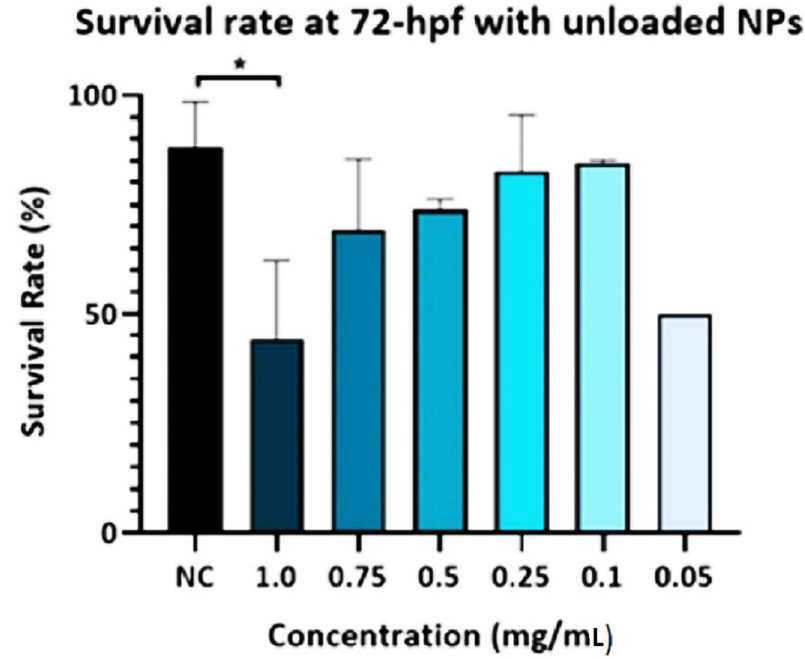
Figure 1. Survival rate of zebrafish embryos exposed to unloaded PLGA-PEG-PLGA NPs. The survival rate of the zebrafish embryos at 72 h post-fertilizing (hpf) was calculated for the negative control (NC) and the treated groups of different concentrations of unloaded PLGA-PEG-PLGA NPs. The survival rate of embryos exposed to unloaded PLGA-PEG-PLGA NPs (1 mg/mL) significantly decreased the survival rate of embryos compared to the NC, at 72 hpf. * = p < 0.05.